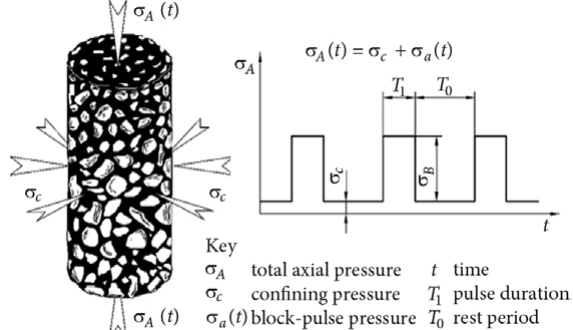
Fig. 2. The principle of sample loading by block-pulse cyclic impulses according to EN 12697-25:2005 Table 1. The test conditions for wearing course according to EN 13108-20:2008 Layer Test temperature